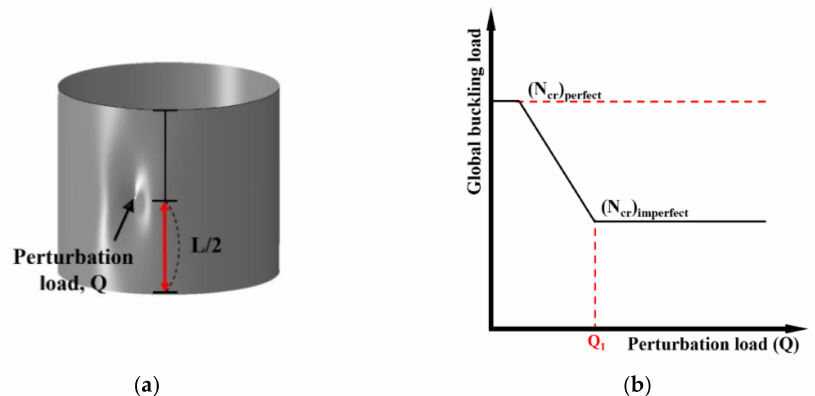
Figure 4. Geometric initial imperfection and convergence of global buckling load in SPLA [16]. ( a ) A perturbation load (Q), ( b ) Global buckling load vs. perturbation